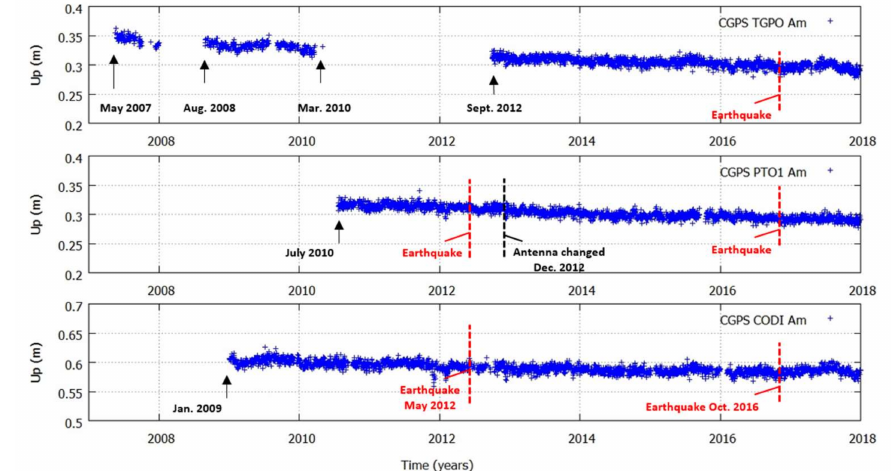
Figure 4. Daily continuous GPS time-series (CGPS) from the three analyzed stations (blue points). Nearby earthquakes (red vertical dashed lines), occurred on 20 May 2012 (Mw 6.0), 29 May 2012 (Mw 5.8) and 30 October 2016 (6.6), and equipment change (black vertical dashed line) occurred on December 2, 2020, are also